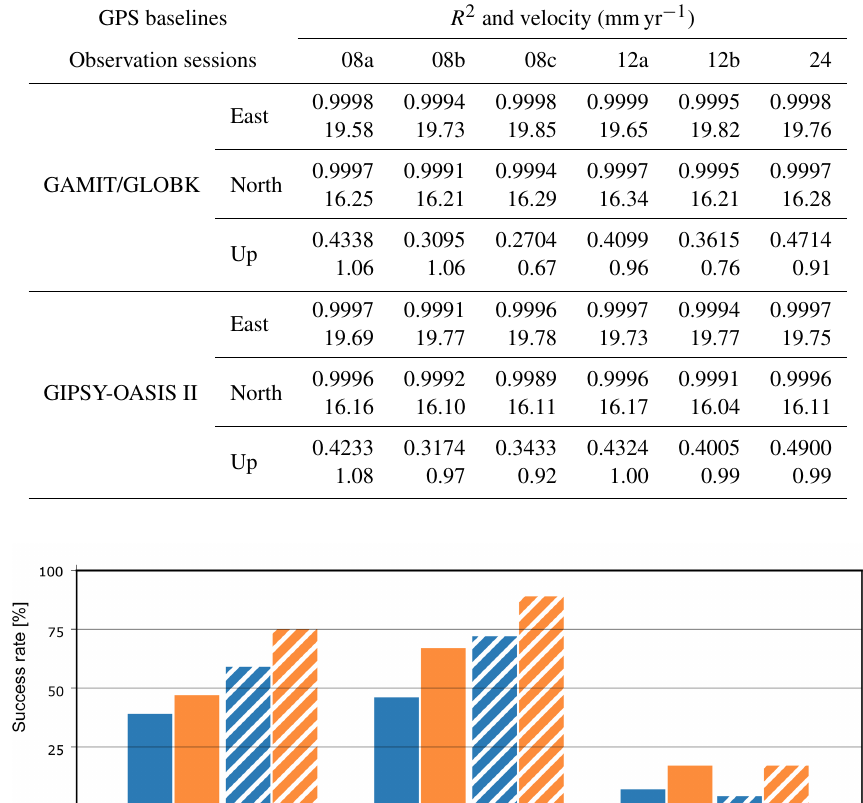
Table 2. Site velocities and R 2 values from both solutions for the site ZIMM.